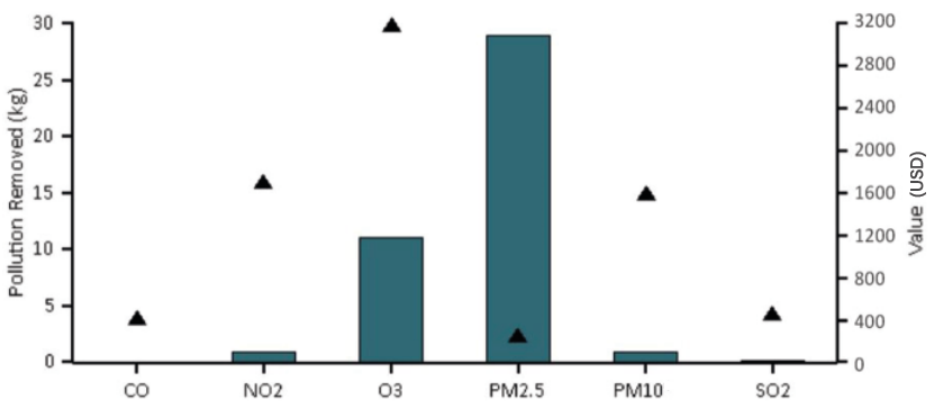
Figure 5. Annual pollution removal and value by tree. Triangle represent Removal.